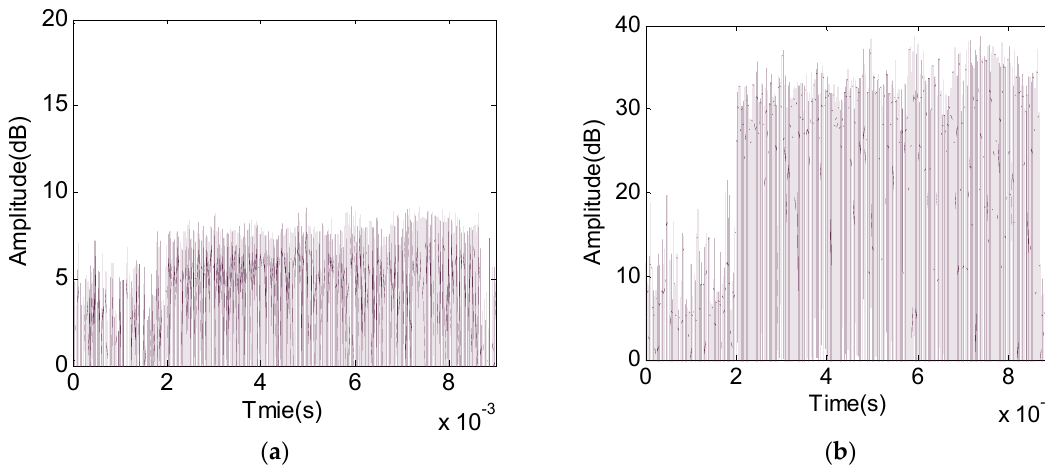
Figure 5. Magnitude of collected 9 ms data: ( a ) Magnitude of the collected data after filtering with the Iridium ring alert signal frequency band; ( b ) magnitude of collected data after square quadratic square processing and filtering with the Iridium ring alert signal frequency band.